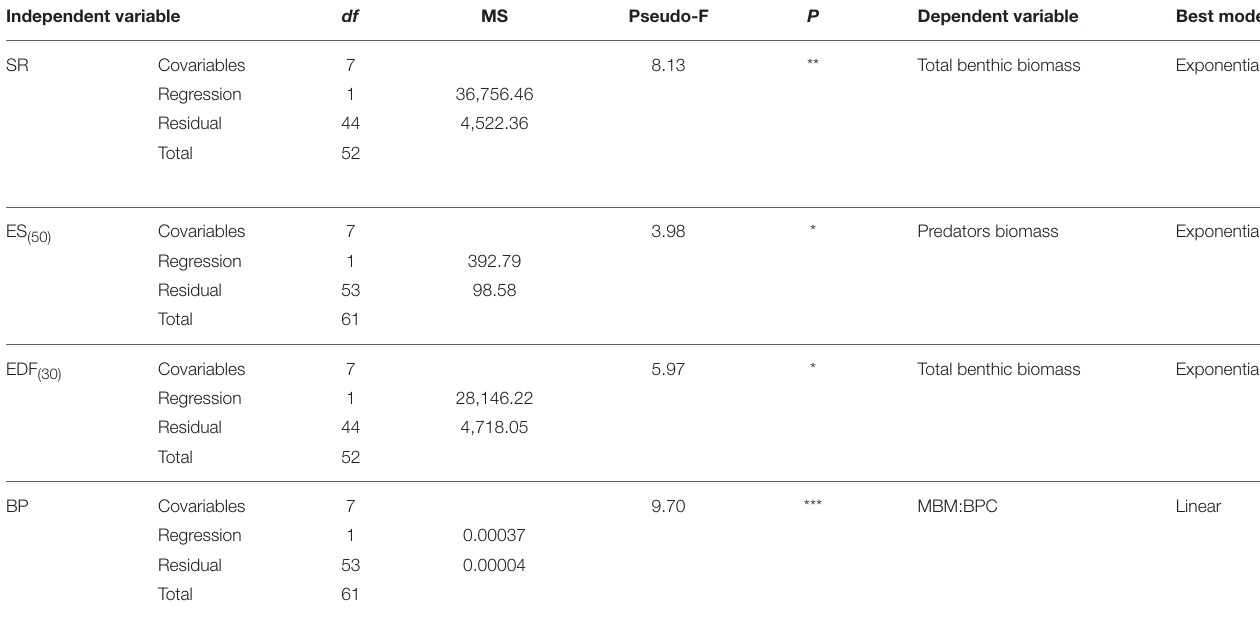
TABLE 3 | Large-scale